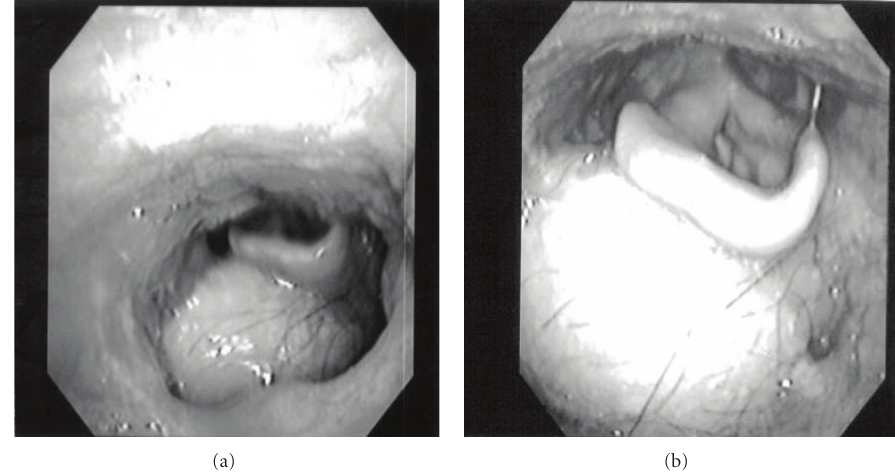
Figure 4: (a) The base of tongue was reconstructed by using a rectus abdominis myocutaneous flap. In this case of reconstructive surgery, we formed the base of tongue by heaping up the base of tongue and raised larynx also for function of swallowing. (b) The airway is well- maintained after resection and reconstructive